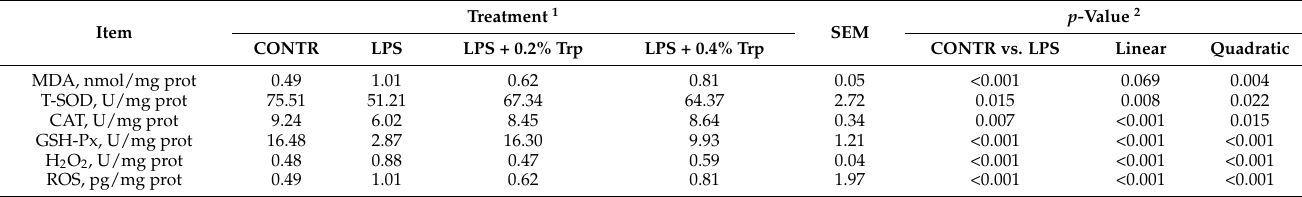
Table 4. Impact of tryptophan on ileal antioxidant capacity after 4 h LPS challenge in piglets.